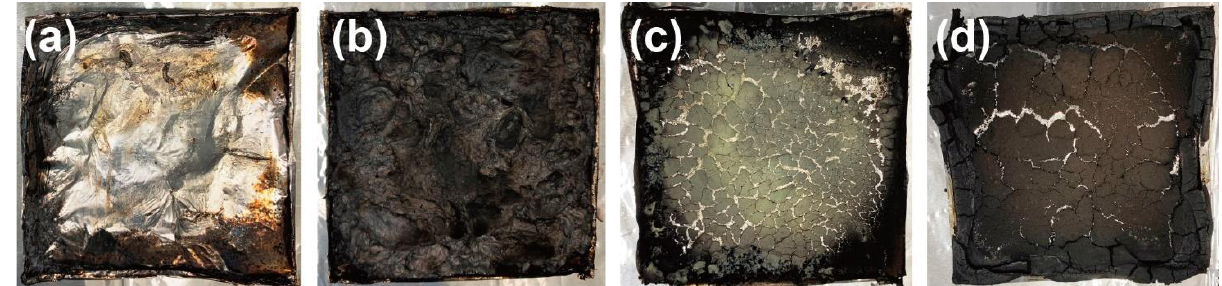
Figure 6. Digital images of char residues of the PLA samples after cone tests. ( a ) pure PLA, ( b ) PLA/APP, ( c ) PLA/serpentine, and ( d ) PLA/serpentine@APP.